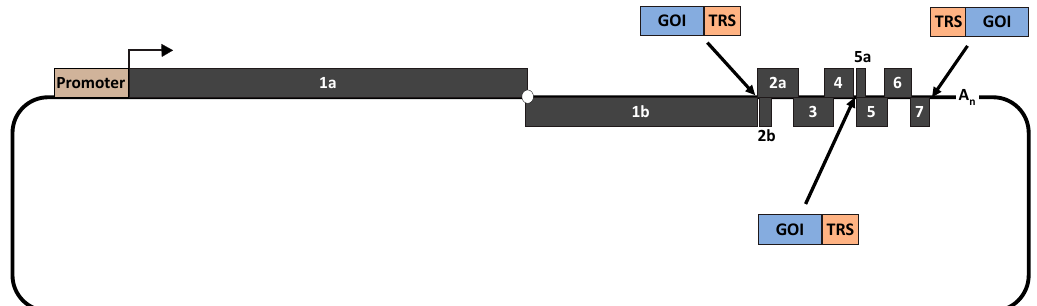
Figure 2. Schematic representation of the potential locations where a gene of interest (GOI) can be inserted into the PRRSV genome. When a GOI is inserted between ORF1b and ORF2a or between ORF4 and ORF5a, its expression will be driven by a transcription regulatory sequence (TRS) located in ORF1b and ORF4, respectively. Consequently, an additional TRS needs be incorporated to the GOI 3 (cid:48) terminus to drive the expression of ORF2a and ORF5. When the GOI is inserted between ORF7 and the 3 (cid:48) UTR, the TRS needs to be incorporated upstream of the GOI to drive its